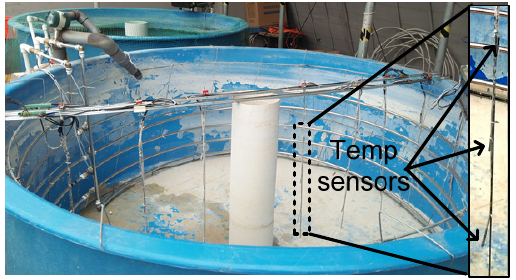
Figure 7. A photo of the experimental setup.